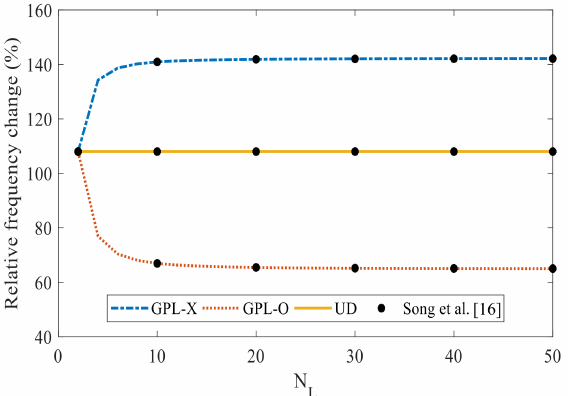
Figure 8. Relative frequency variation vs. the number of layers, for different GPL distribution patterns ( b / a = 1, a / h = 10, and SSSS boundary